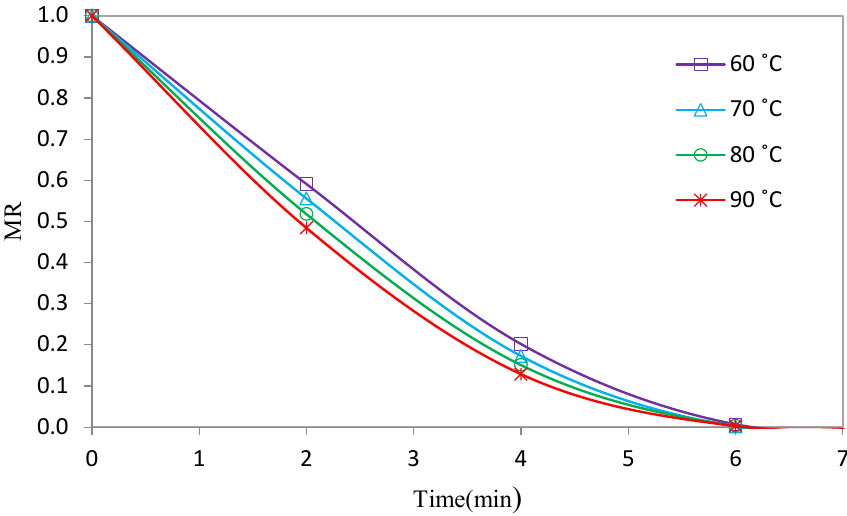
Fig. 1. Variation of moisture ratio versus drying time for calcium carbonate samples at different drying temperature.